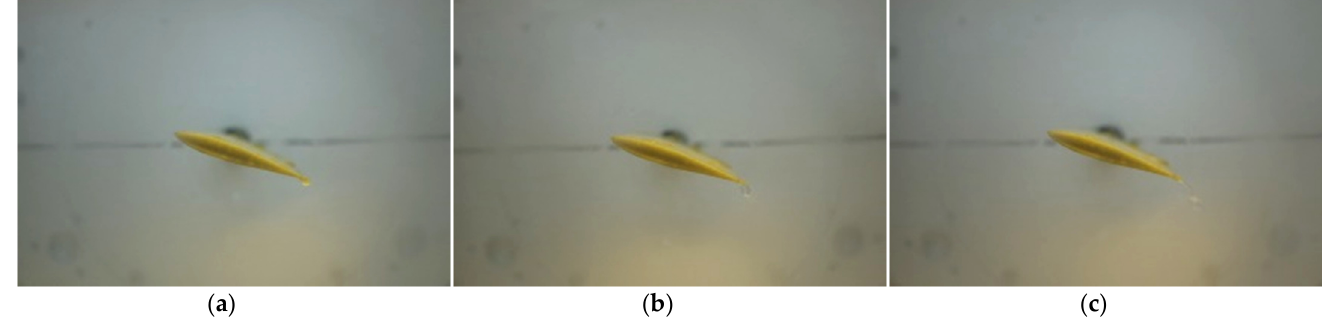
Figure 17. (a – c) Frames from the formation of water film over the wing during the two-phase flow experiment in the wind tunnel and the detachment of water from the trailing edge.